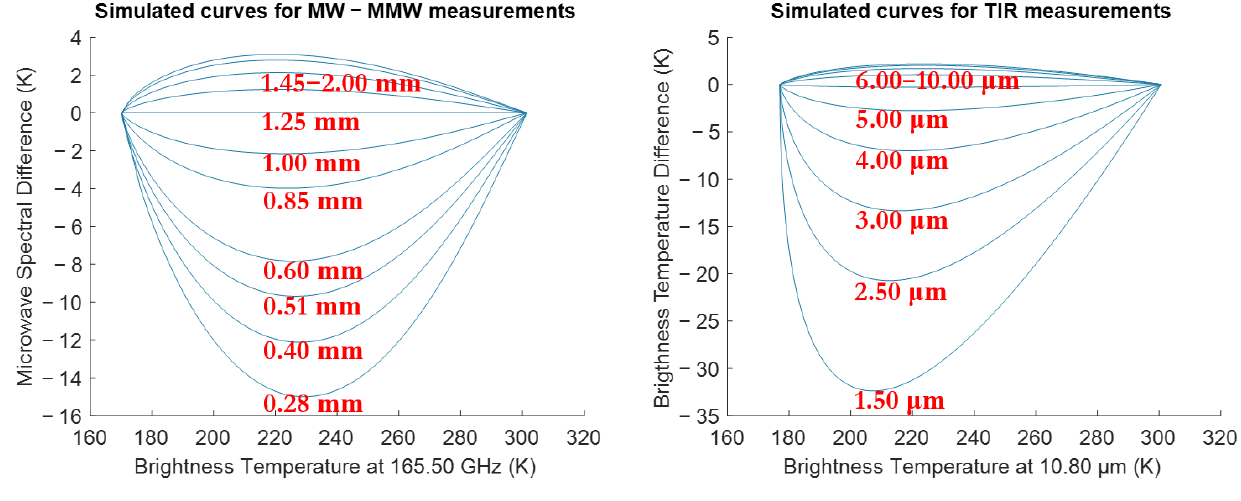
Figure 3. Block diagram of MW-MMW and TIR retrieval procedure. The first orange block computes the particle size distribution (PSD) using the particle density, effective radius and concentration. The second block is involved to retrieve cloud physical properties. It first computes extinction cross- section (based on Mie Theory) considering refractive index and wavelength, then the volumetric extinction cross-section given PSD and σ e . Finally, the optical depth is estimated by considering k e and geometric thickness ( l ). The third block simulates the BTs considering the surface temperature, the layer temperature ( T n ), the PSD, the optical depth and the emissivity. The BT λ is the simulated BT at a given wavelength. The fourth block performs the retrieval using two methods: the MLE and NN. Figure 4 shows the solution of the RTM A plotted in arch curves. For both MW-MMW and TIR curves, we return the associated effective radius. For MW-MMW we show the effective radius interval that goes from 0.28 to 2.00 mm. Instead, for TIR measurements, we show the effective radius interval from 1.50 to 10.00 µ m.